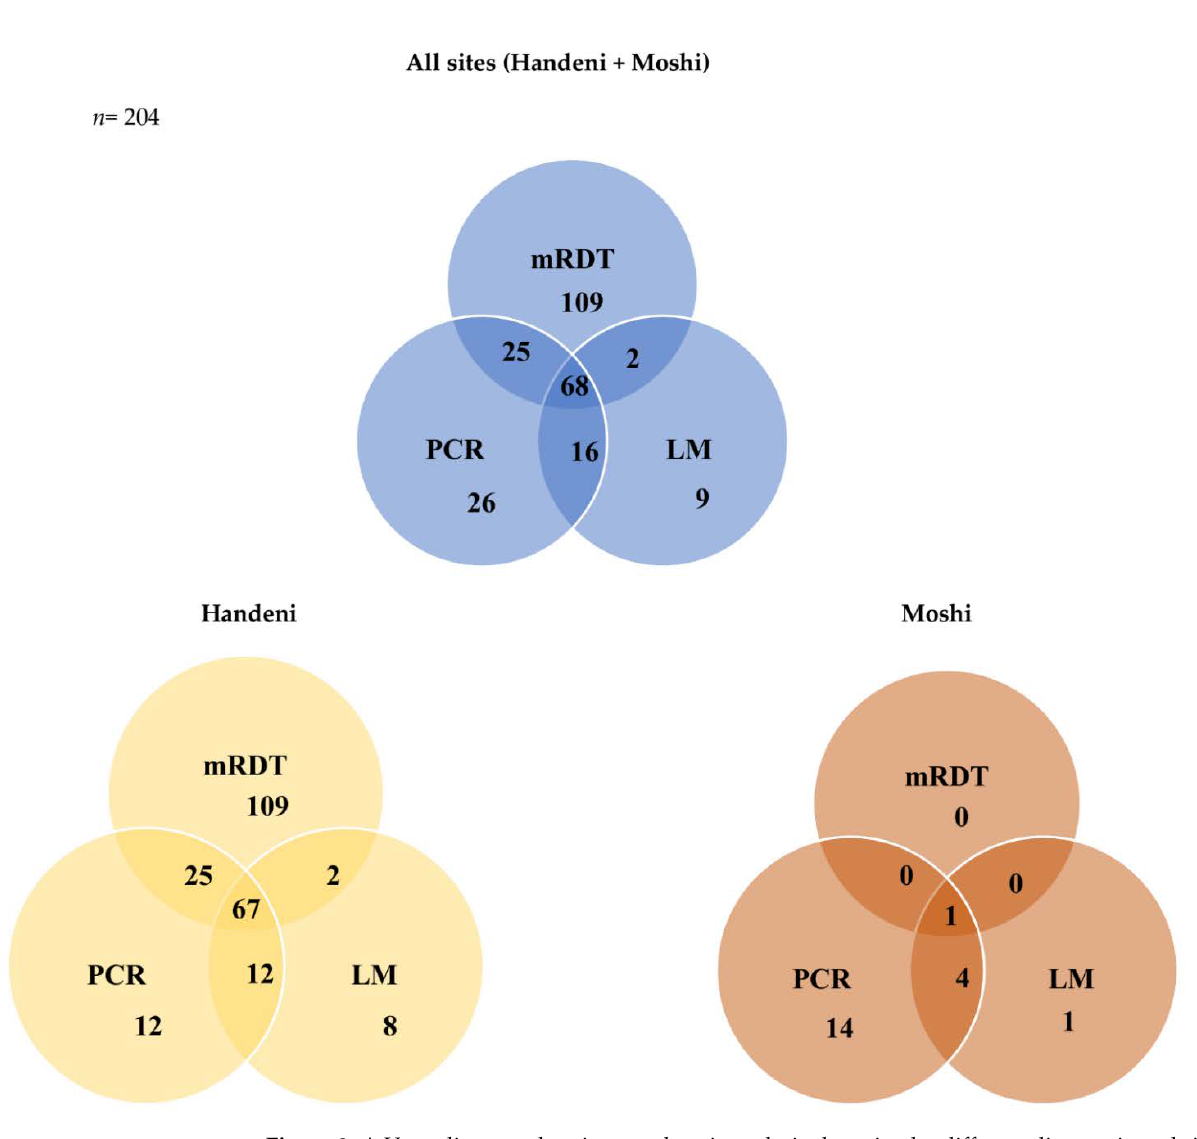
Figure 3. A Venn diagram showing overlaps in malaria detection by different diagnostic tools in the study sites.